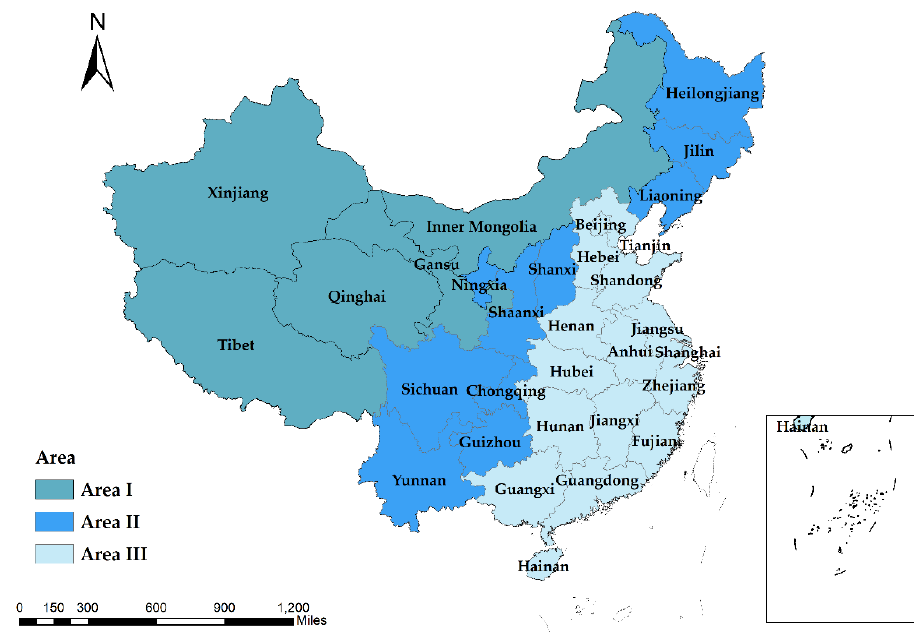
Figure 5. The three areas after combination of the seven livestock geographical